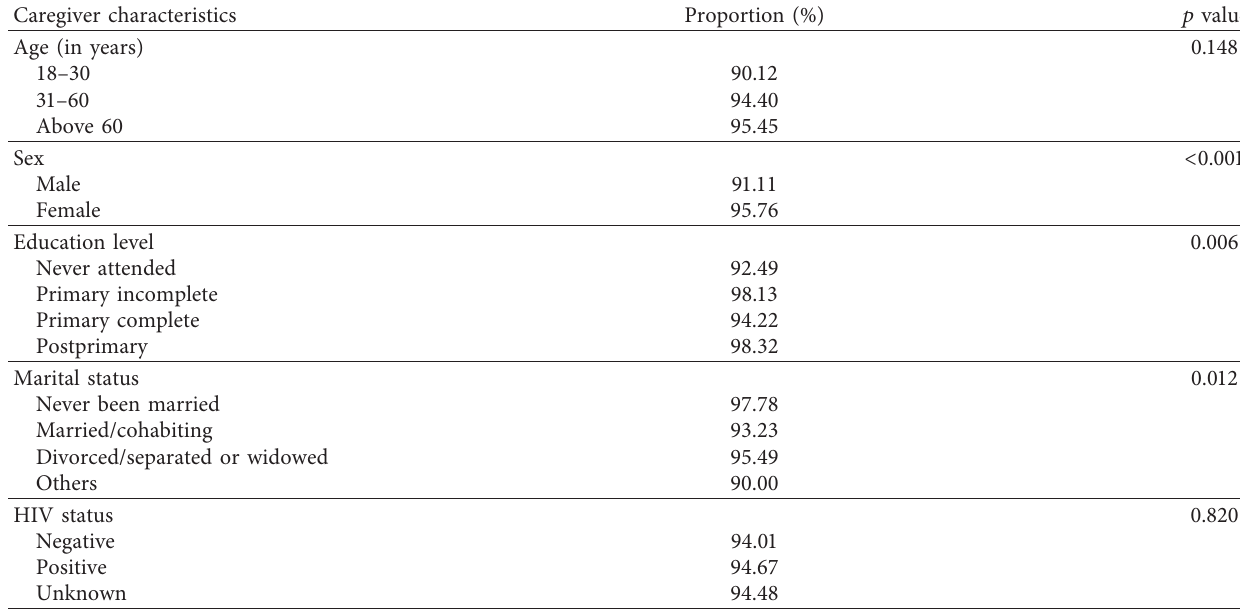
Table 4: Proportion of OVC in a household with multiple OVCLHIV who all had their HIV status disclosed to them by their caregivers with different characteristics.